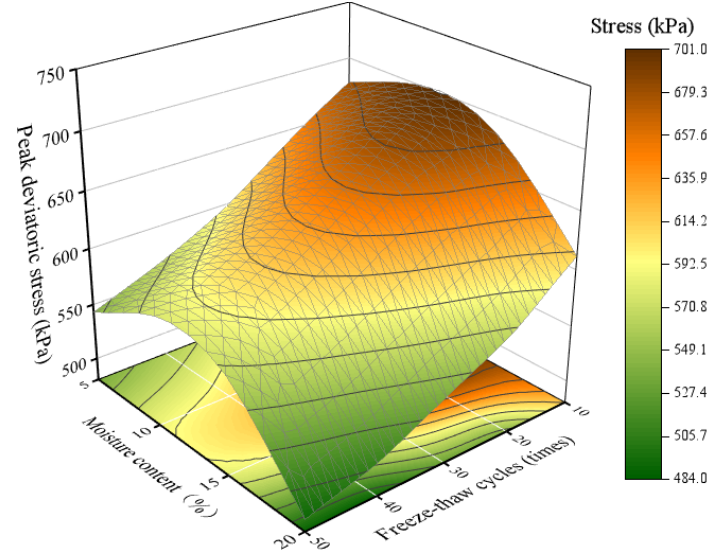
Figure 5. Shear strength of tailings under different moisture content.